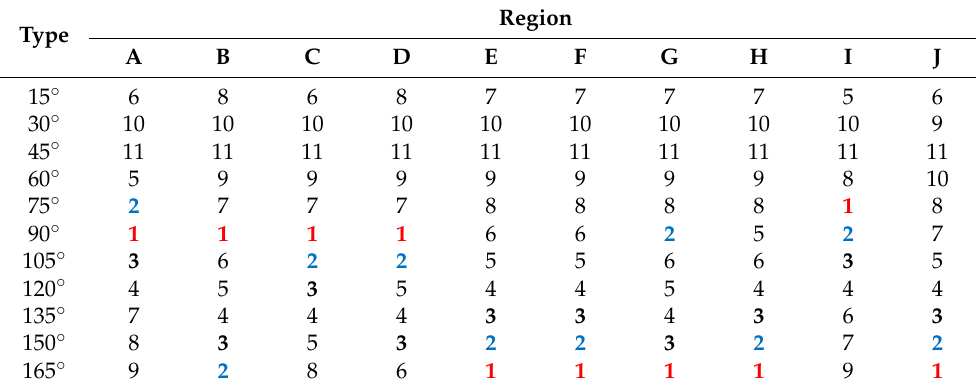
Table 13. Ranks of optimized installation angles for a kinetic louver in autumn.